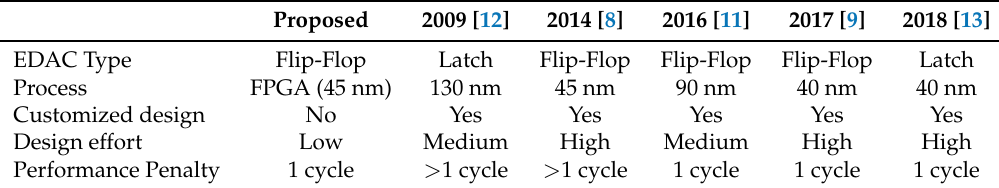
Table 1. Comparisons with other EDAC